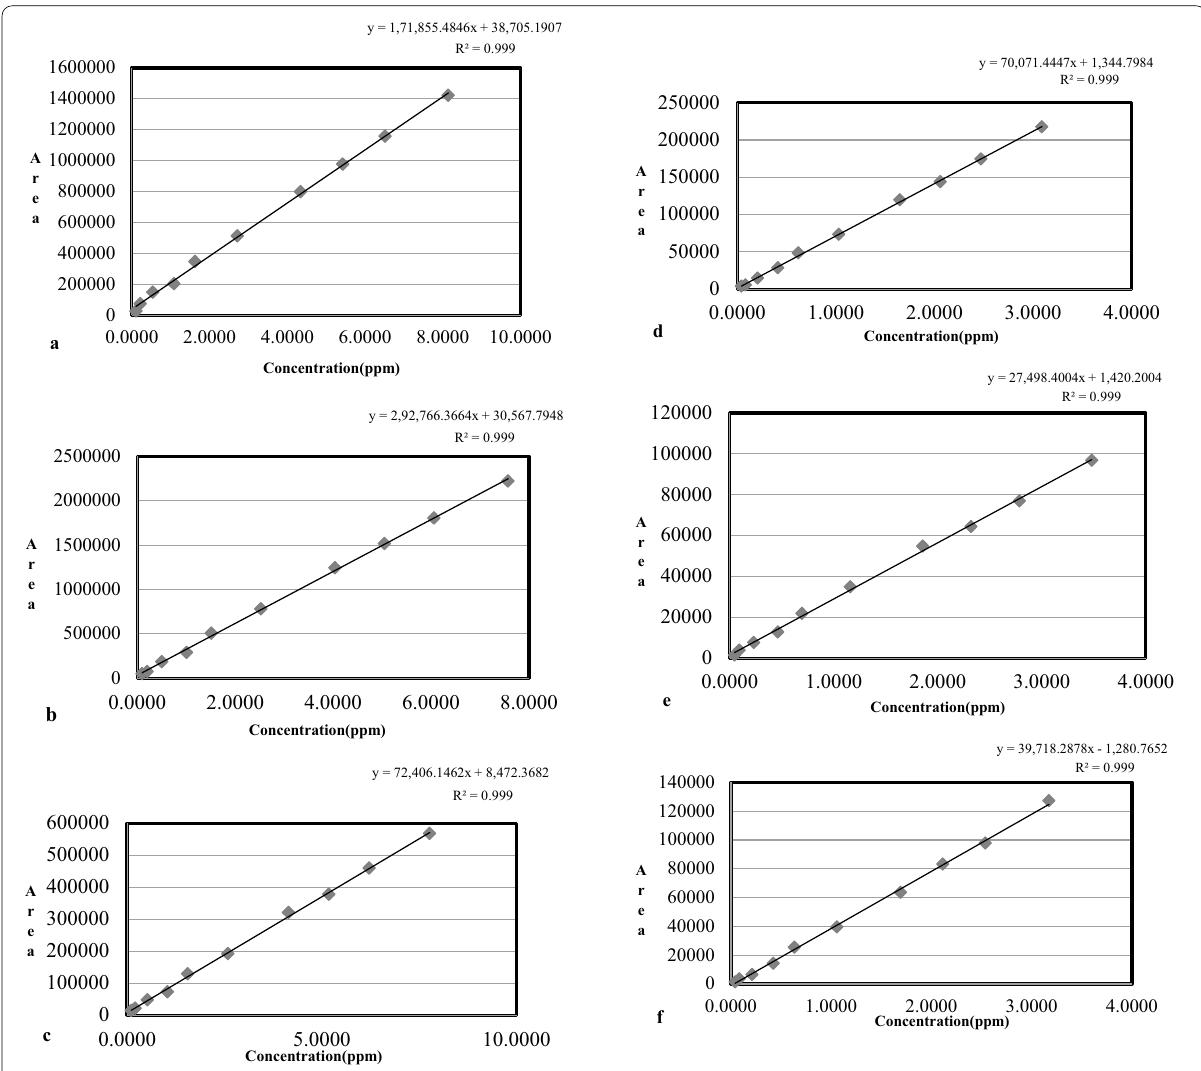
Fig. 3 a Linearity of cyanoguanidine, b linearity of melamine, c linearity of MTF, d linearity of TNG impurity A, e linearity of TNG impurity B, f linearity of